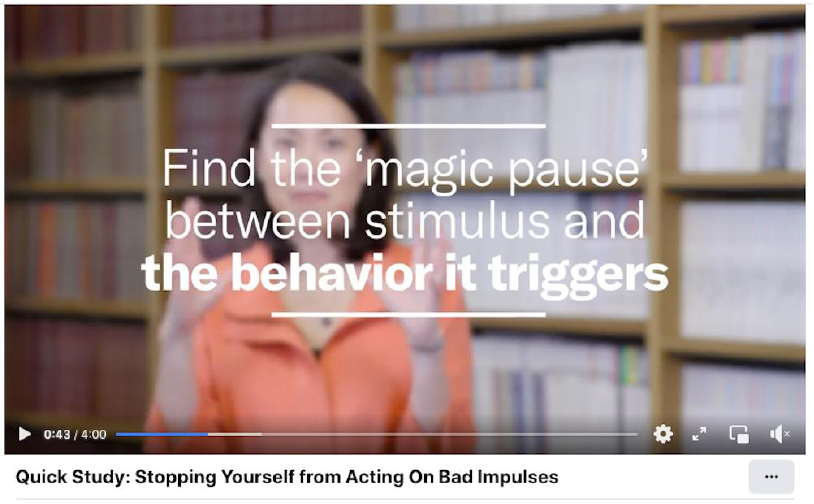
Figure 1. The researcher explaining while her words are superimposed on screen in Q2.